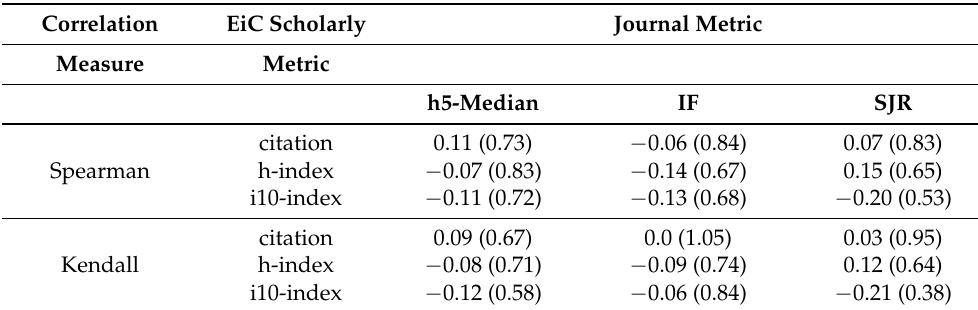
Table 4. Correlation between various pairs of the EiC and journal-level metrics in MI Journal ( p -values are shown inside parentheses).